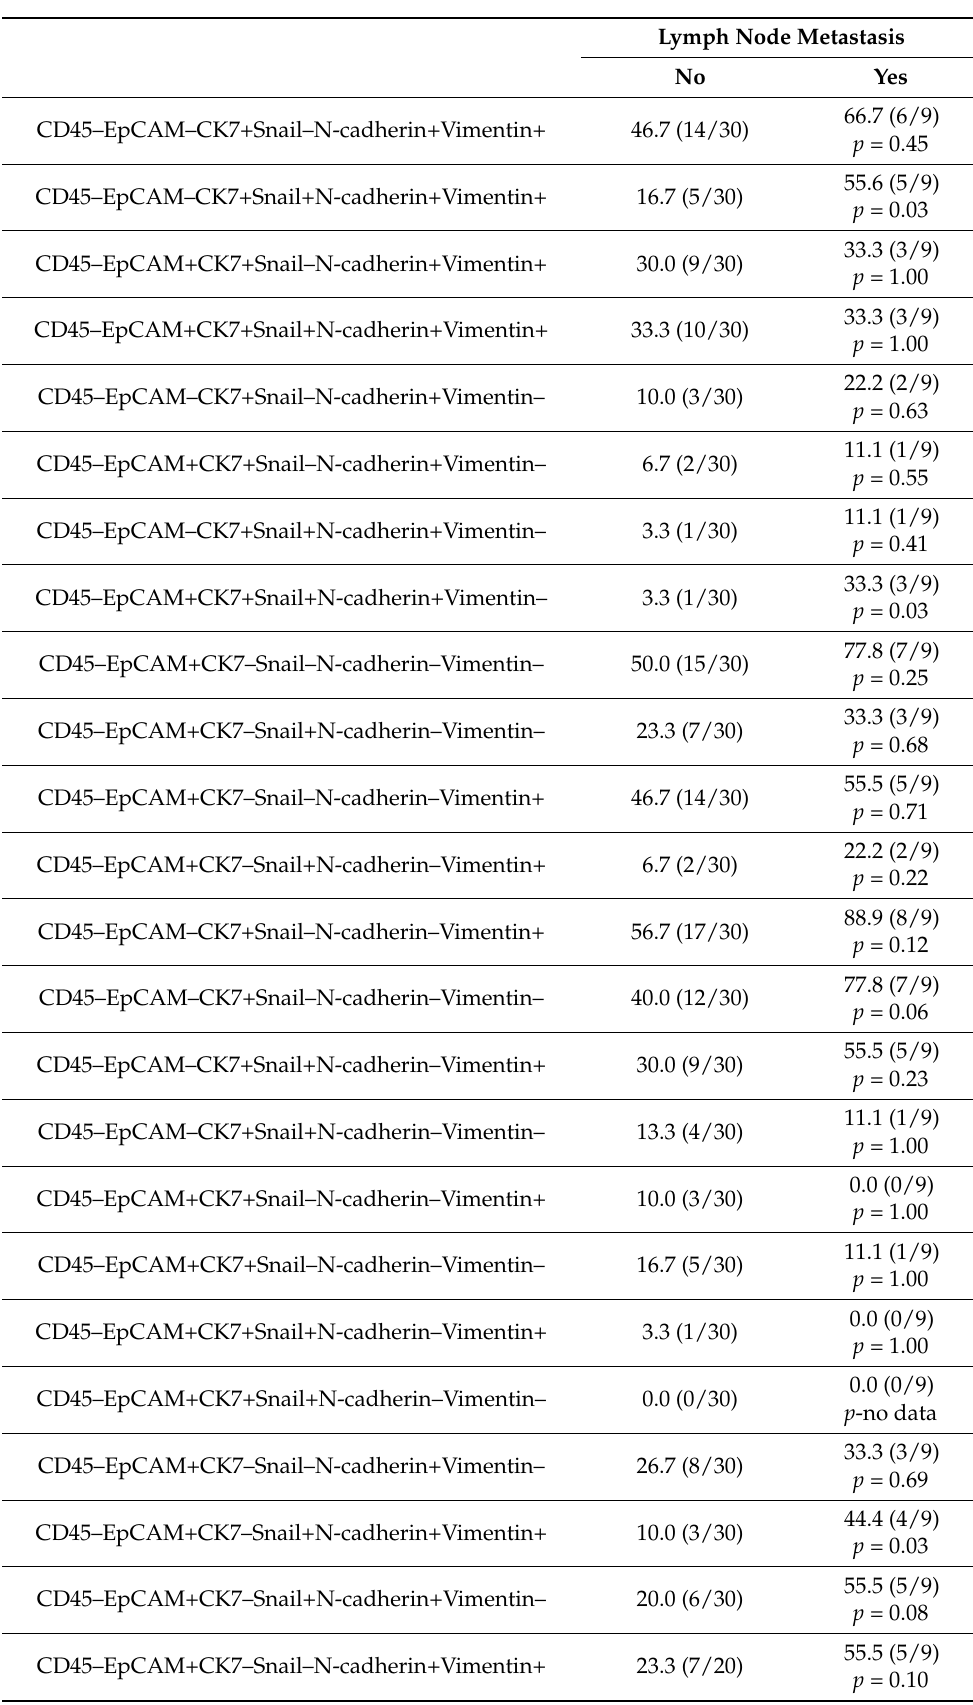
Table 3. The frequencies of 24 studied CTC phenotypes in groups of patients with and without lymphogenous